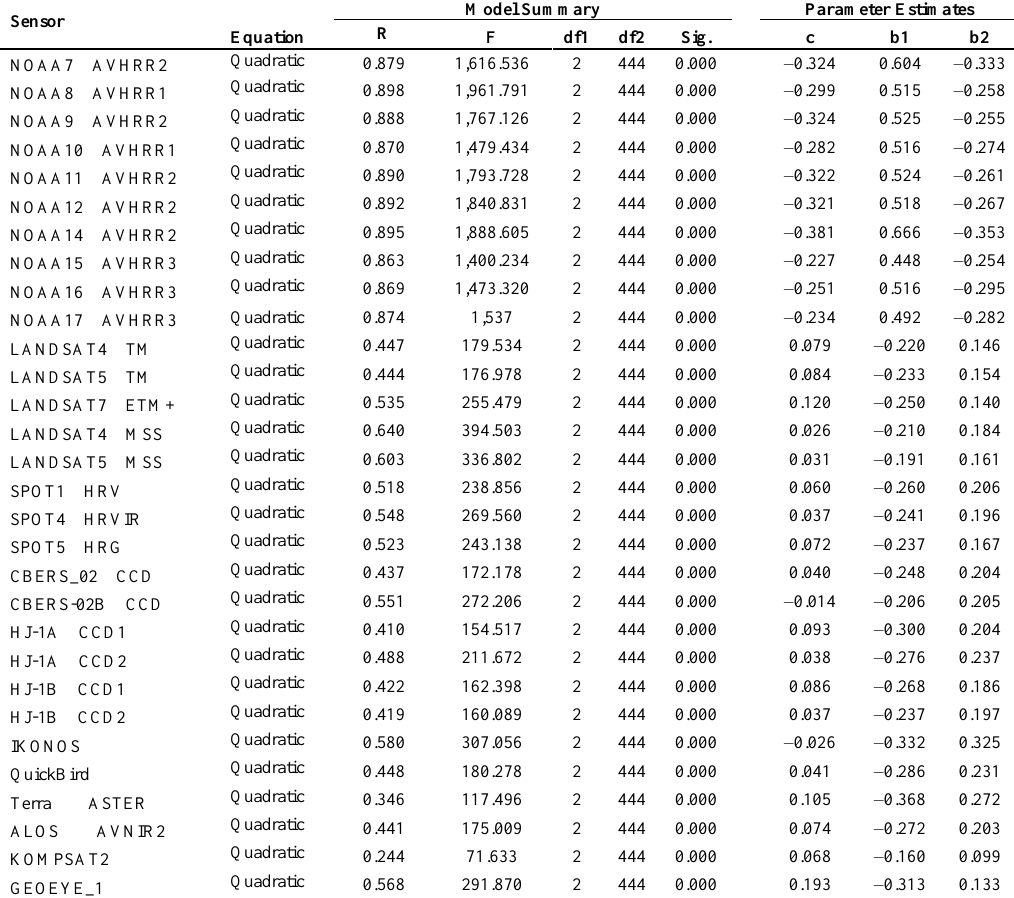
Table 7. Parameters of the polynomial fit to the relative spectral correction for the NDVI. Equation: y = c + b1 x + b2 x 2 , y denotes RPD in the NDVI, x denotes NDVI for particular